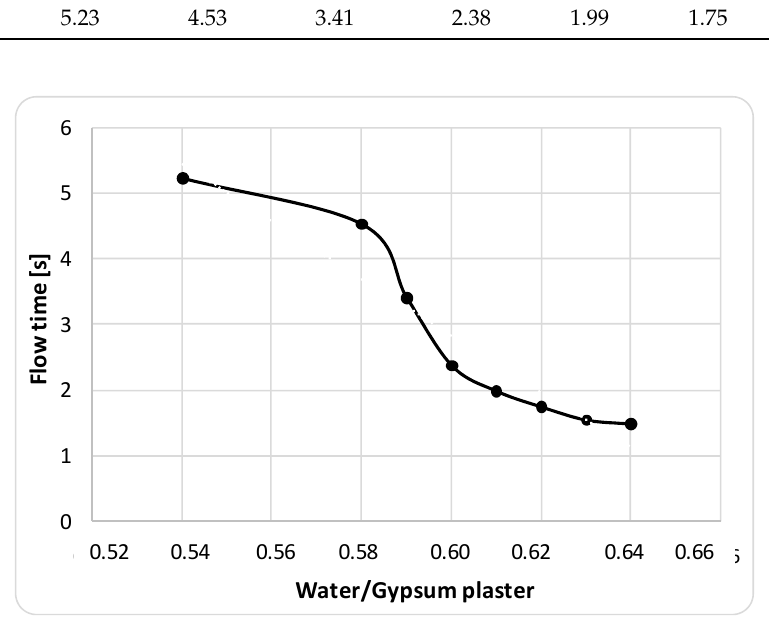
Figure 4. Measurement of flow time using LCL mortar maniabilimeter. Table 3. Results of flow time measurements test.